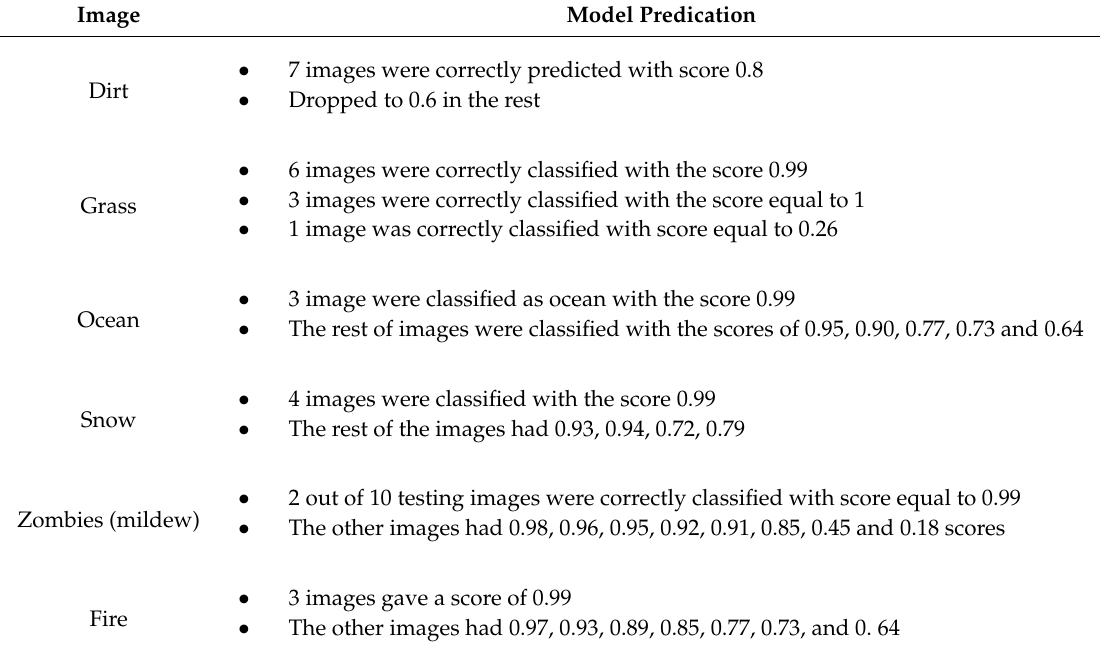
Table 2. Model predications for 10 testing images of single